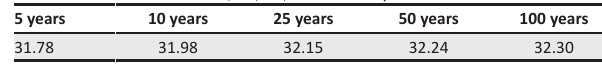
TABLE 3: Return values for 5, 10, 25, 50 and 100